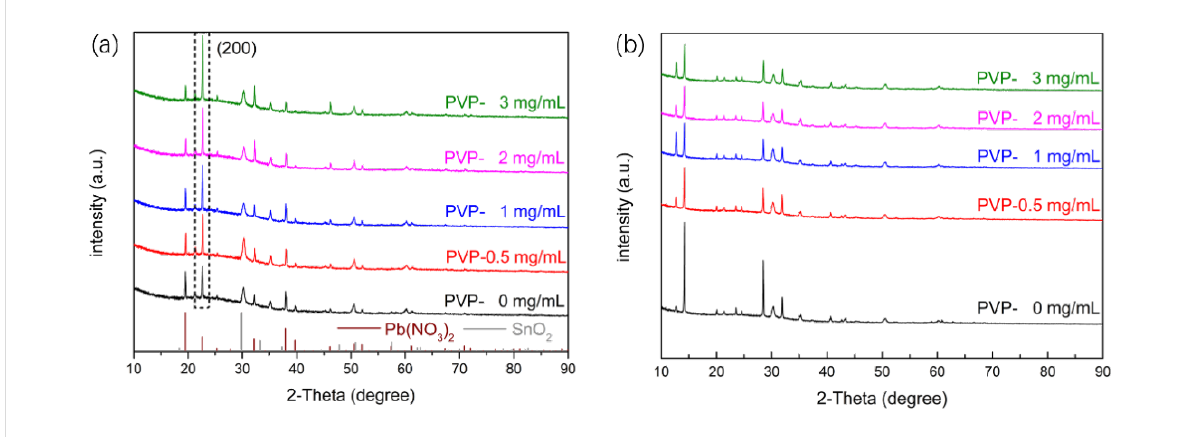
Figure 3: (a) XRD patterns of the Pb(NO 3 ) 2 films with different amounts of PVP additive. (b) XRD patterns of the perovskite films with different amounts of PVP additive.